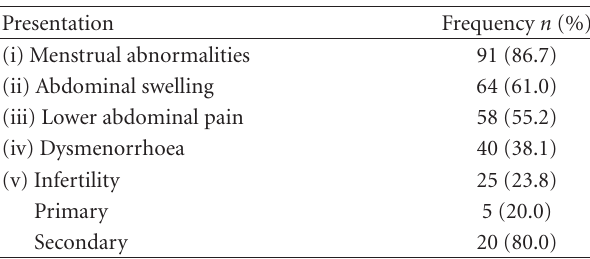
Table 4. There was no maternal